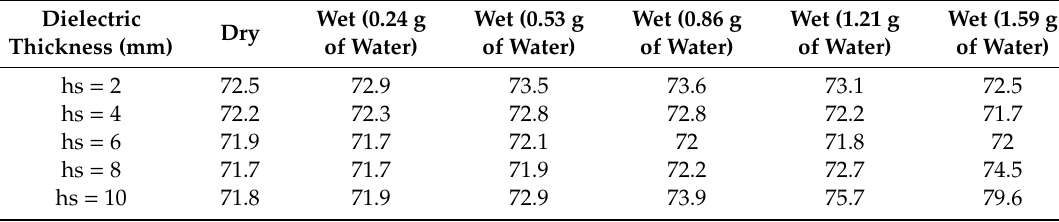
Table 8. Beam width ( ◦ ) of the simulated radiation pattern of antenna performance for the dry and wet conditions at 2.45 GHz.